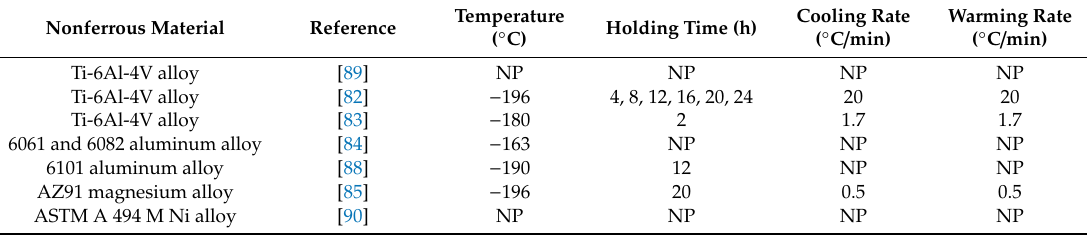
Table 2. Non-ferrous alloys in the